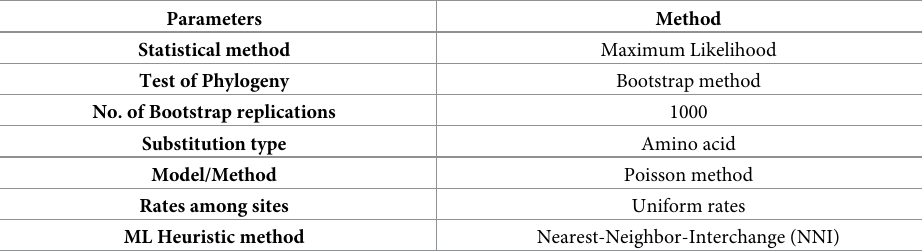
Table 1. Parameters and methods used to predict phylogenetic trees for nephrin, KIRREL1, CD2AP, podocin, and TRPC6 proteins and their orthologous